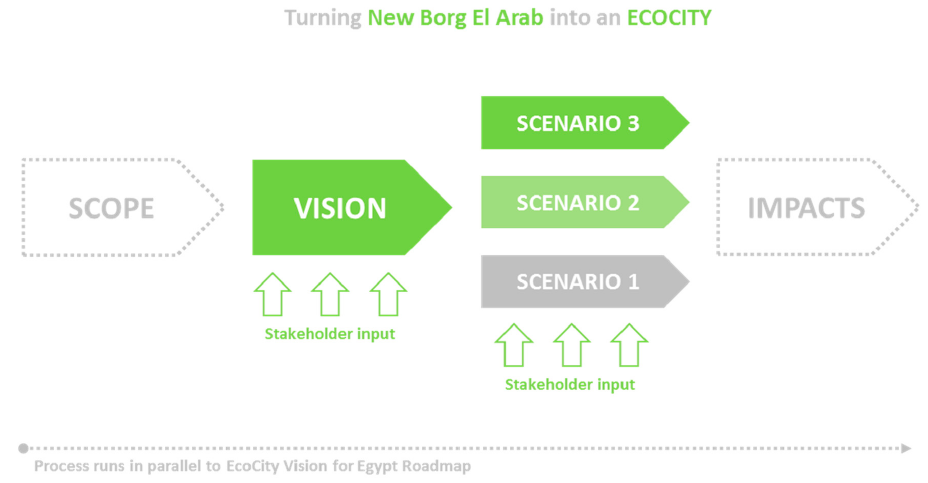
Figure 2. FS development process [27]. Table 1. Vision and targets defined for the Residential sector [27].